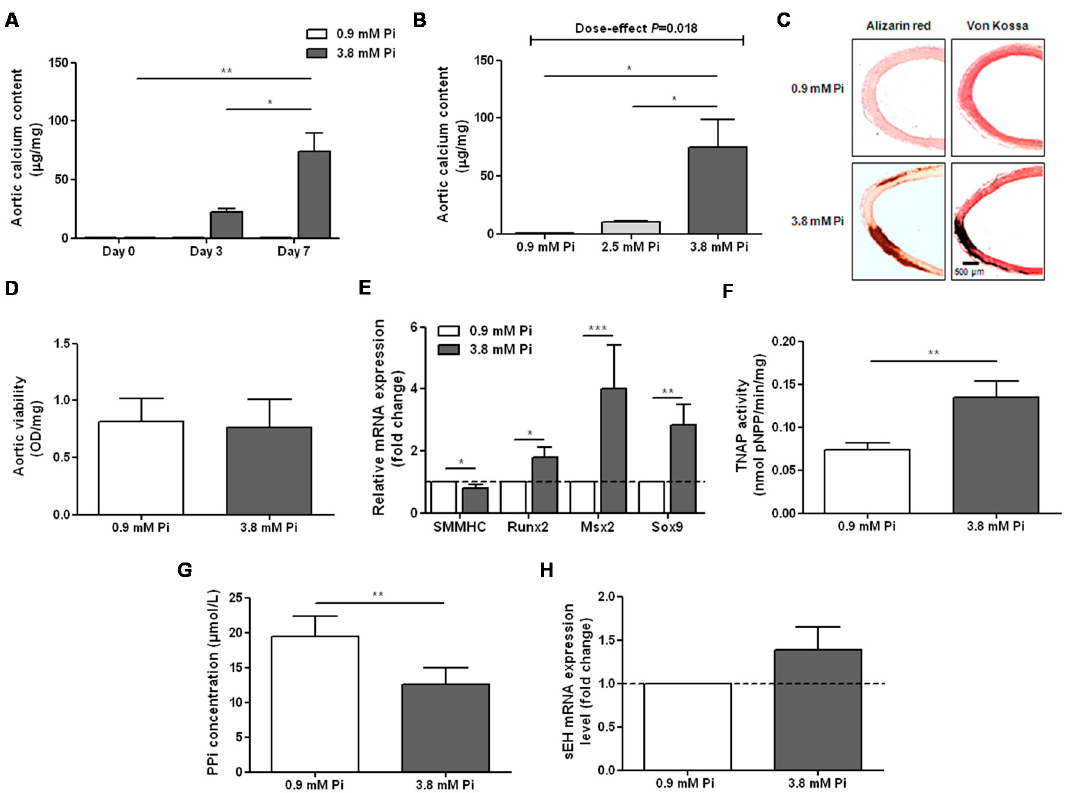
Figure 1. Time- ( A ) and dose- ( B ) dependent effect of inorganic phosphate (Pi) on the calcium content of aortic rings ( n = 4–8 per condition) and representative images of Alizarin red and Von Kossa staining of aortic rings cultured for 7 days in 0.9 mM and 3.8 mM Pi ( C ): The impact of high-phosphate conditions on the viability of rat aortic rings was assessed using a methylthiazolyldiphenyl-tetrazolium assay (( D ) n = 4 per group). Aortic mRNA expression levels of the contractile marker smooth muscle myosin heavy chain (SMMHC) and of the osteochondrogenic markers runt-related transcription factor 2 (Runx2), Msh homeobox 2 (Msx2) and sex-determining region Y-box 9 (Sox9) after 7 days of culture in normal (0.9 mM Pi) and high-phosphate (3.8 mM Pi) conditions (( E ) n = 10–24 per group). Tissue-nonspecific alkaline phosphatase (TNAP) activity ( F ) assessed by measuring the hydrolysis of p-nitrophenyl phosphate (pNPP) and pyrophosphate anions (PPi) level ( G ) in the supernatants of aortic rings cultured for 7 days in 0.9 mM and 3.8 mM Pi ( n = 14 per group). Aortic mRNA expression levels of soluble epoxide hydrolase (sEH) after 7 days of culture in 0.9 mM and 3.8 mM Pi ( H ). * p < 0.05, ** p < 0.01 and *** p <